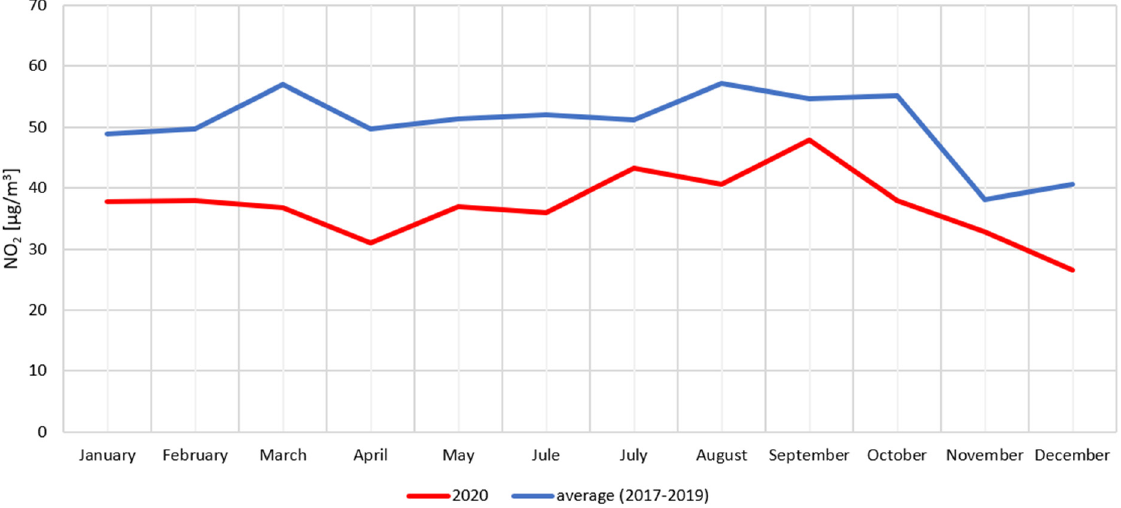
Figure 5. Mean NO 2 concentrations in al. Niepodleg ł o ś ci in 2020 compared to the mean concentrations from 2017 to 2020. Calculation based on all days of the year (developed by the author).